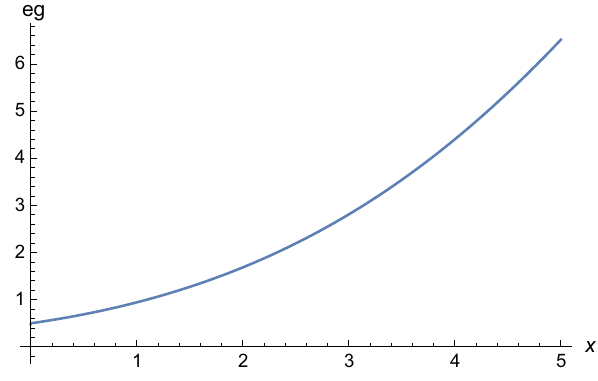
Fig. 1 The plot of eg versus x = m C R for the case n = 1. In the limit m C → 0 ( i.e. x → 0) one recovers eg = 1 . For any non-zero mass and 2 non-zero separation x > 0 one finds that the product eg will be greater than for the usual Dirac condition. This implies that the strength of the magnetic charge is even larger in the presence of symmetry